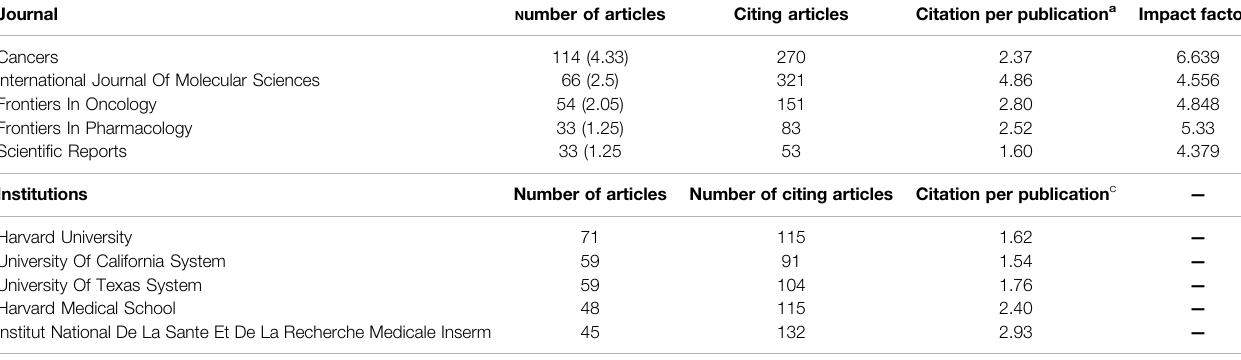
TABLE 5 | Most current data on journal and institutional productivity from 2020 to mid-2021.